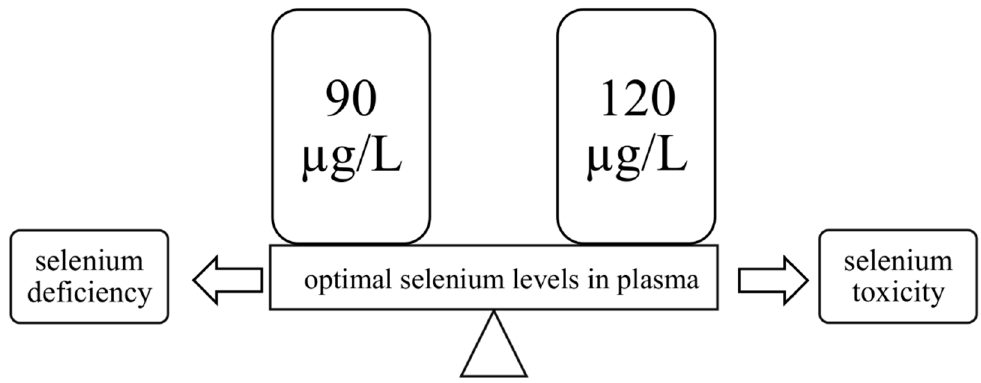
Figure 1. The range of normal (optimal) plasma selenium levels. Values above and below this range indicate selenium toxicity or deficiency, respectively.